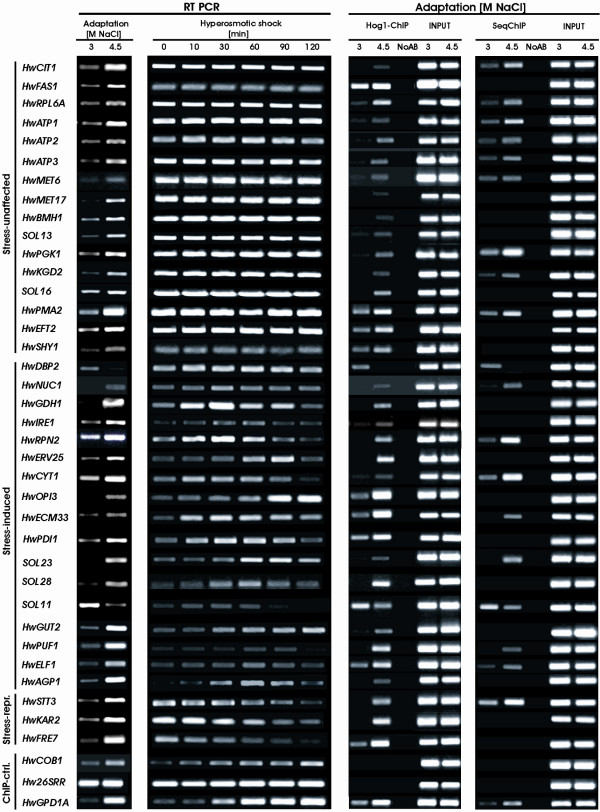
Expression profiles of HwHog-ChIP positive genes in adapted and stressed H. werneckii cells and ChIP results in adapted cells. RT-PCR was performed with RNA isolated from adapted cells (Adaptation) or cells exposed to hypersaline stress (Hyperosmotic stress) as indicated. 26S rRNA (Hw26SRR) was used as an internal control for template normalization. The HwHog1-ChIP and sequential RNA polymerase II/HwHog1-ChIP (SeqChIP) results for cells adapted to 3 M NaCl and 4.5 M NaCl are presented in parallel. The negative control for nonspecific binding of antibodies in both ChIP experiments is represented in the "NoAB" line and the positive control for genomic DNA amplification from 100-fold diluted input samples is labeled as "INPUT". HwCOB1 and 26SRR genes were negative controls and HwGPD1A was the positive control for HwHog1 and RNA polymerase II cross-linking.